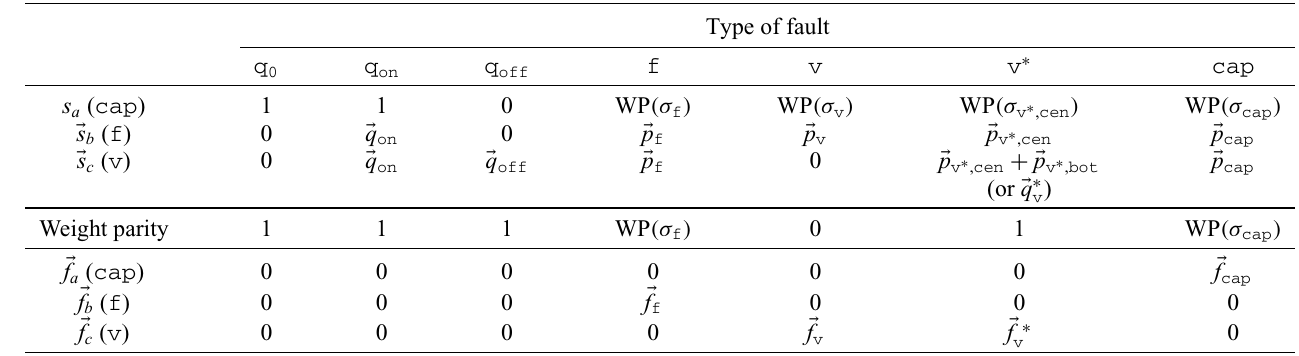
TABLE II. Syndrome (cid:6) s = ( s a , (cid:6) s b , (cid:6) s c ) , weight parity, and flag vector leads to a Z -type error. Here s a , (cid:6) s b , (cid:6) s c are syndromes evaluated by cap , f , and v generators of X type, while obtained from circuits for measuring cap , f , and v generators of Z type. Note that in some cases a syndrome bit is equal to the weight parity of an